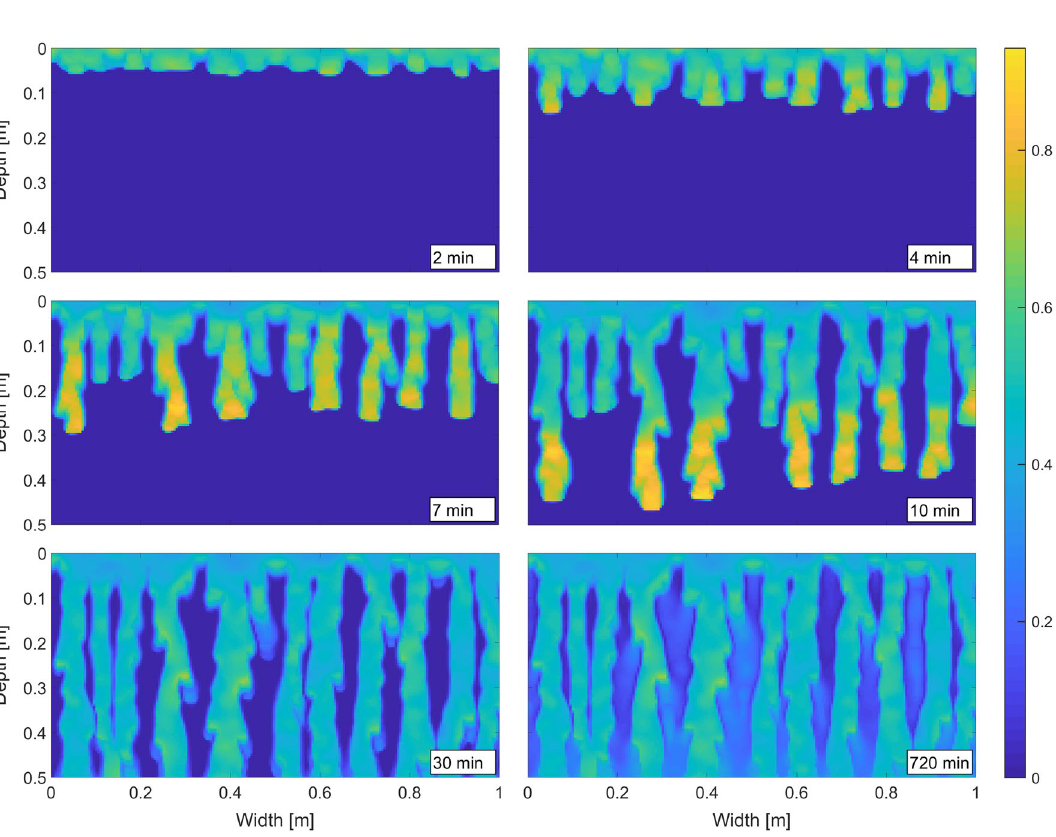
Figure 2. Fingering pattern at various simulation times. Constant flux over the top boundary into an almost dry isotropic porous medium. See Table 1 for the simulation parameters. For details, refer to the text. Saturation values are colour-coded according to the colour bar on the